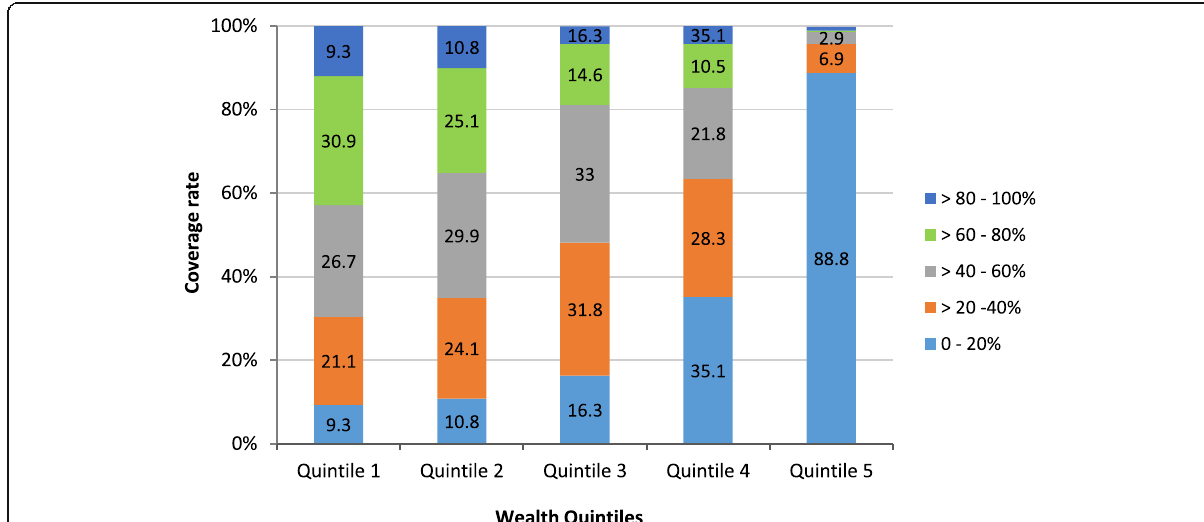
Fig. 4 Numbers and percentages of clusters categorized by the spatially smoothed coverage rates of unimproved water. The percentage of clusters with 0-20% of unimproved water coverage declined, while the percentage of clusters with 60-80% rise in the first four quintiles after the spatial smoothing process